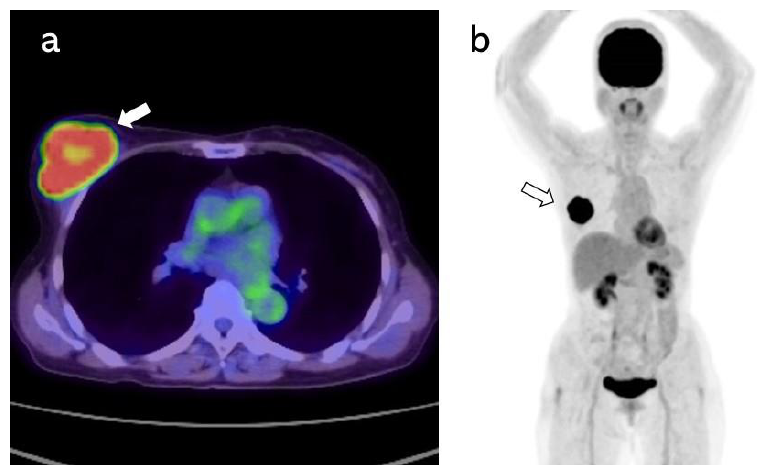
Figure 3. 18F-Fluorodeoxyglucose positron-emission tomography/computed tomography shows high uptake mainly on the periphery of the tumor ( a , b : arrow). No other areas of uptake indicated a suspected distant metastasis on whole-body maximum intensity projection imaging ( b ).